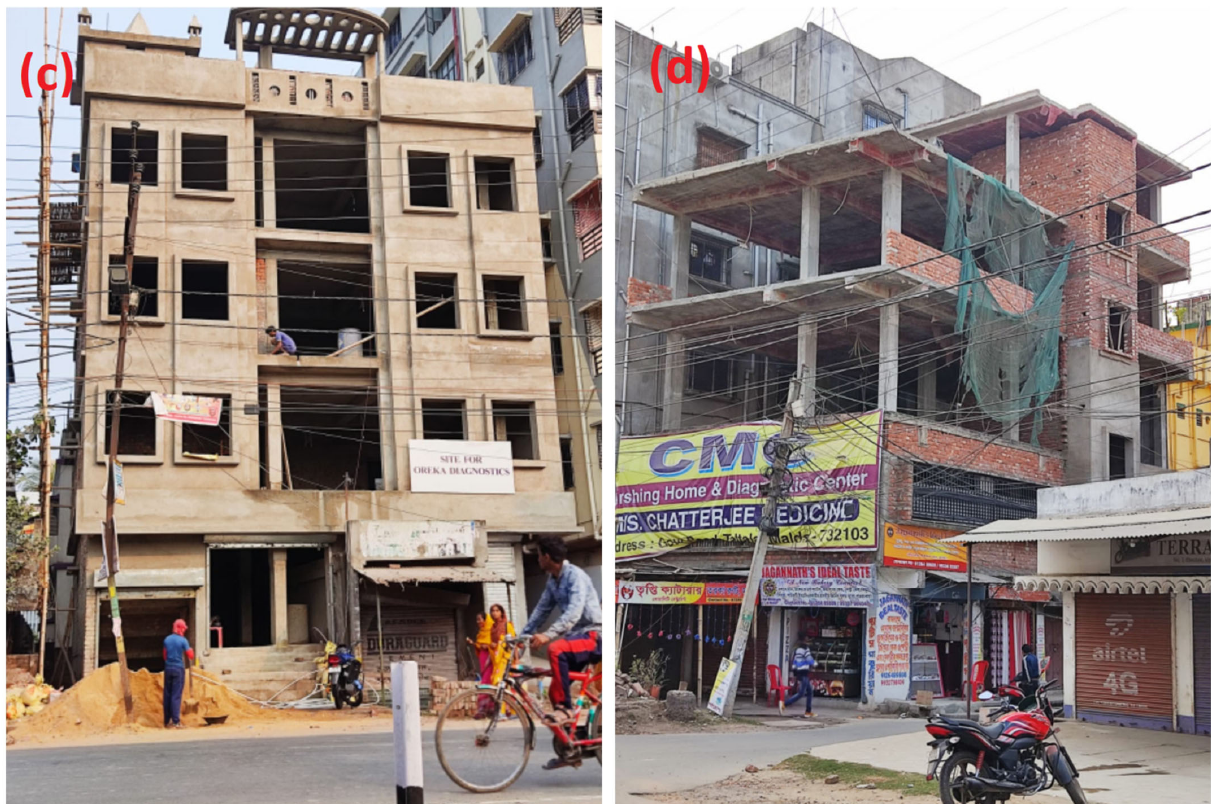
Figure 10. Under construction built-up areas on national highway-34 beyond the administrative boundary of the municipal areas, such as ( a ) a housing lodge at Gabgachi (1 km away from the University of Gour Banga); ( b ) a car showroom at the nearby area of Gabgachi , which can help to emerge other allied services in very soon upcoming days; ( c ) nursing home towards Gazole (another emerging site for the built-up area), which will help other allied services, hotels, restaurant, and others in the upcoming days; and ( d ) a shopping mall at Madhabnagar (southwards from the municipal areas), which will help to grow new built-up areas, like a garage, petrol stations, small shops, and